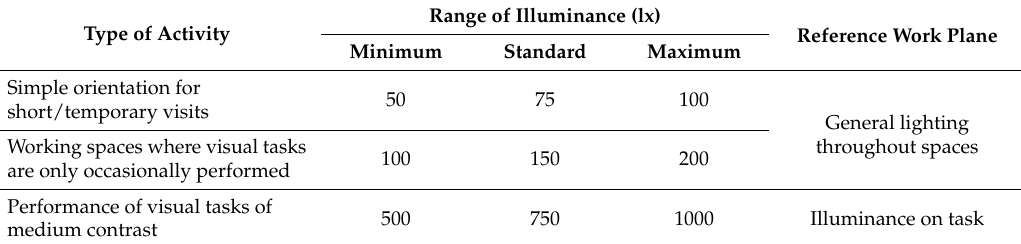
Table 5. KS A 3011 Recommended levels of illumination.